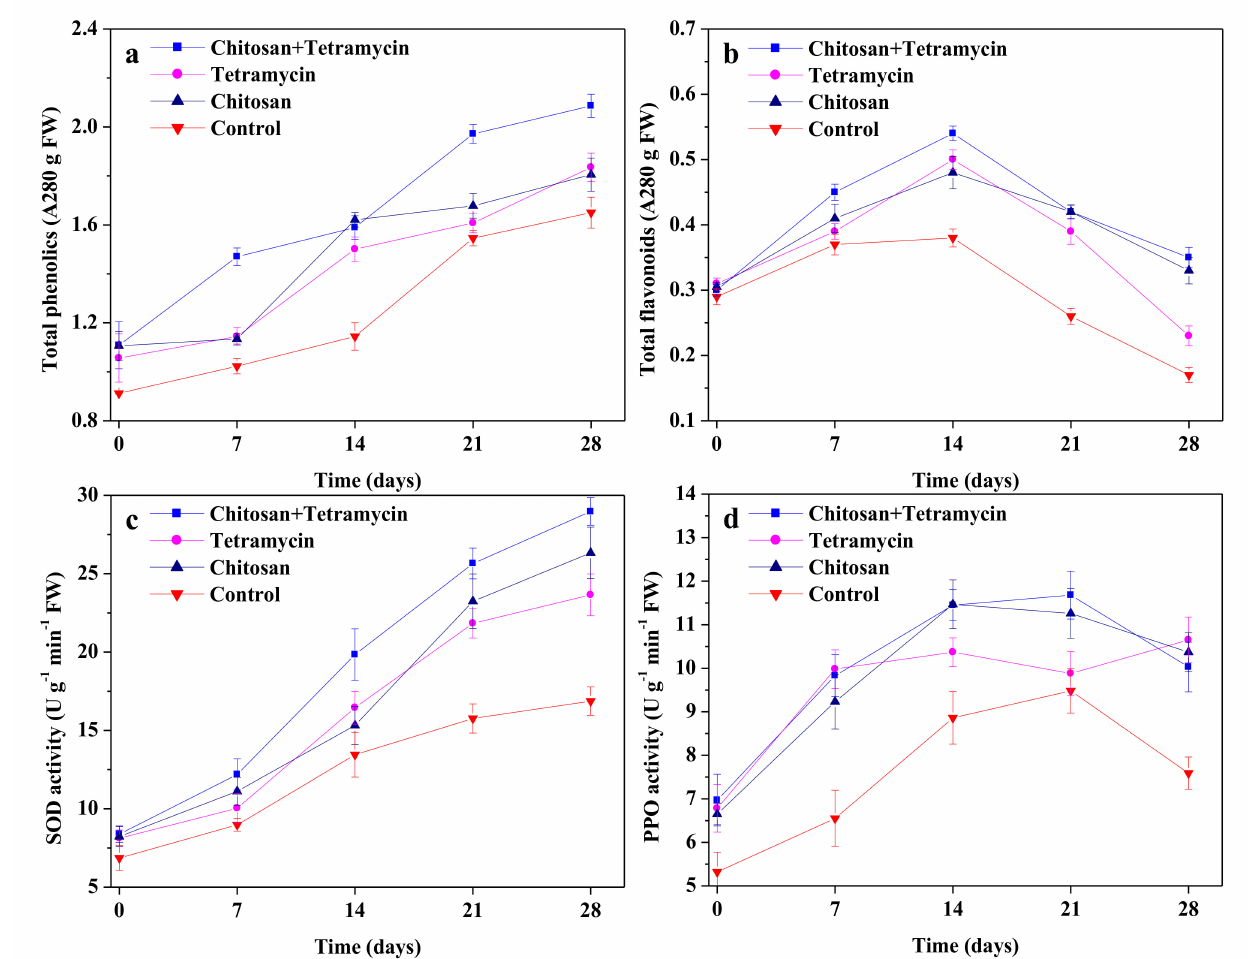
Figure 1. The effects of chitosan and tetramycin on the changes of total phenolics ( a ) and total flavonoids ( b ), SOD activity ( c ) and PPO activity ( d ) in kiwifruit during storage. Values and error bars indicate the mean and SD of three replicates, respectively.